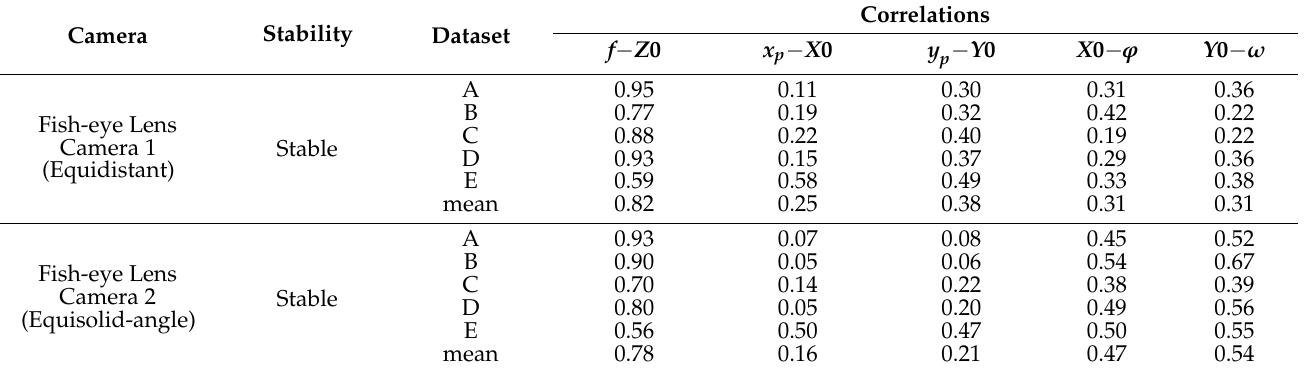
Table 10. Stability and correlations in real